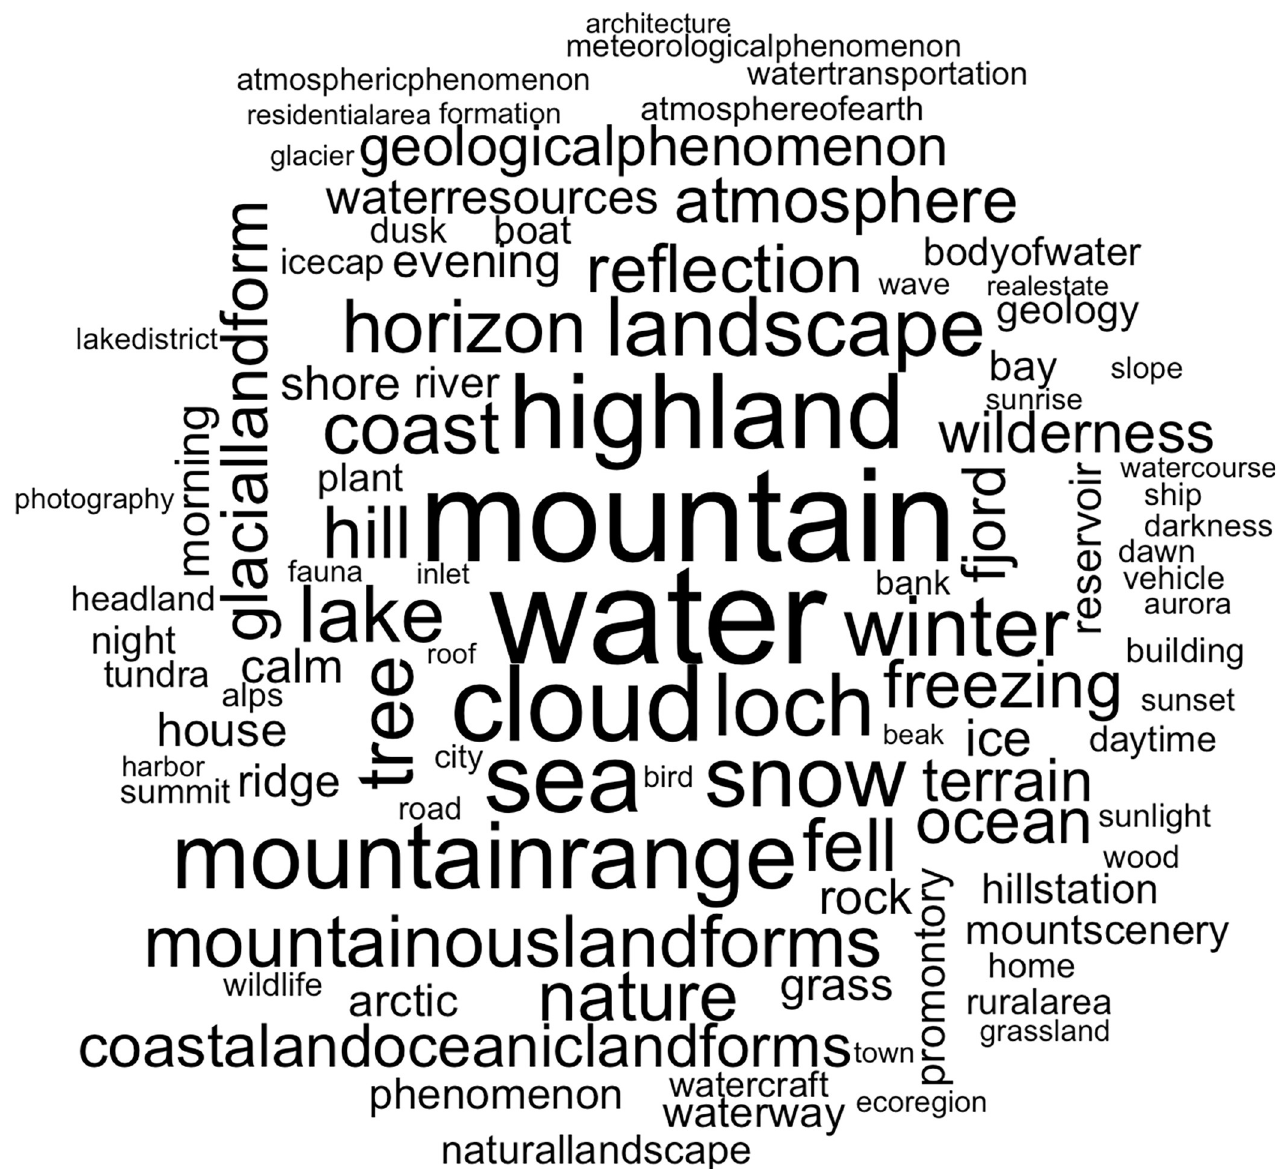
Fig 2. Word cloud of all photograph labels. The fond size represents the prevalence of each word in the dataset.